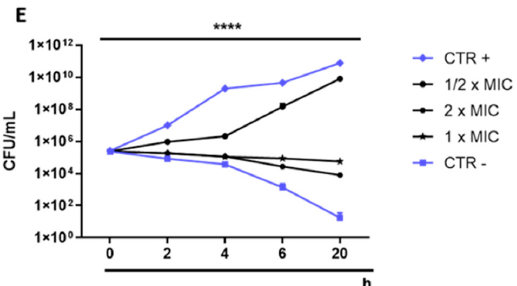
Figure 3. Time-killing of IDSK on: ( A ) Escherichia coli , **** p < 0.0001; ( B ) Staphylococcus aureus , **** p < 0.0001; ( C ) Salmonella enterica *** p = 0.0003; ( D ) Enterococcus faecalis , **** p < 0.0001; ( E ) Pseudomonas aeruginosa , **** p < 0.0001.